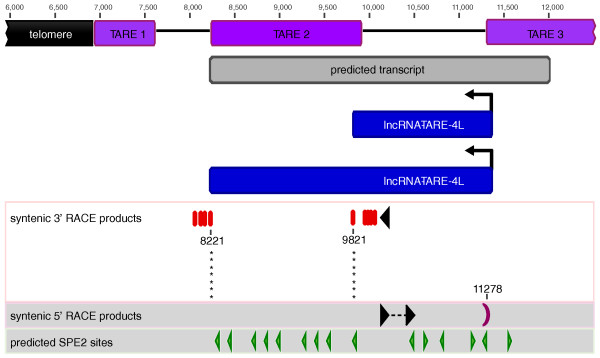
RACE suggests two long telomere-associated transcripts are transcribed in the TARE 2-3 region. 3' RACE products of seven distinct lncRNA-TARE sequences terminated at a precise syntenic site on either side of TARE 2 (asterisks). Taken together with the 5' RACE product suggests two species approximately 1.5 kb and 3.1 kb in length are transcribed towards the telomeres from the TARE 3 boundary. Genome-wide, the palindromic SPE2 DNA motif (green triangles) is enriched only in the TARE 2-3 region from which lncRNA-TARE is transcribed and in the upstream promoter element of upsB-type var genes. Primers are depicted as black triangles and numbers represent base-pair coordinates corresponding to the left end of chromosome 4. SPE2, subtelomeric var gene promoter element 2.